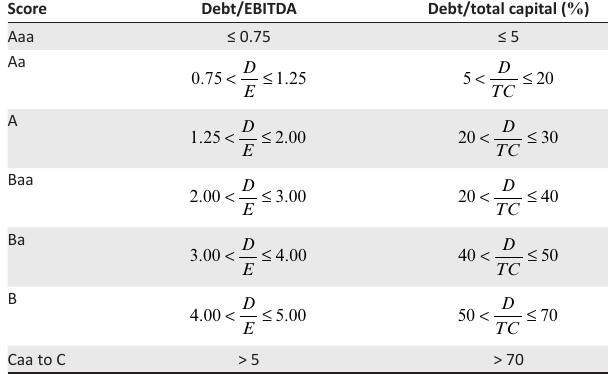
TABLE 5: Assumed simplified quantitative rules of the external agency methodology for